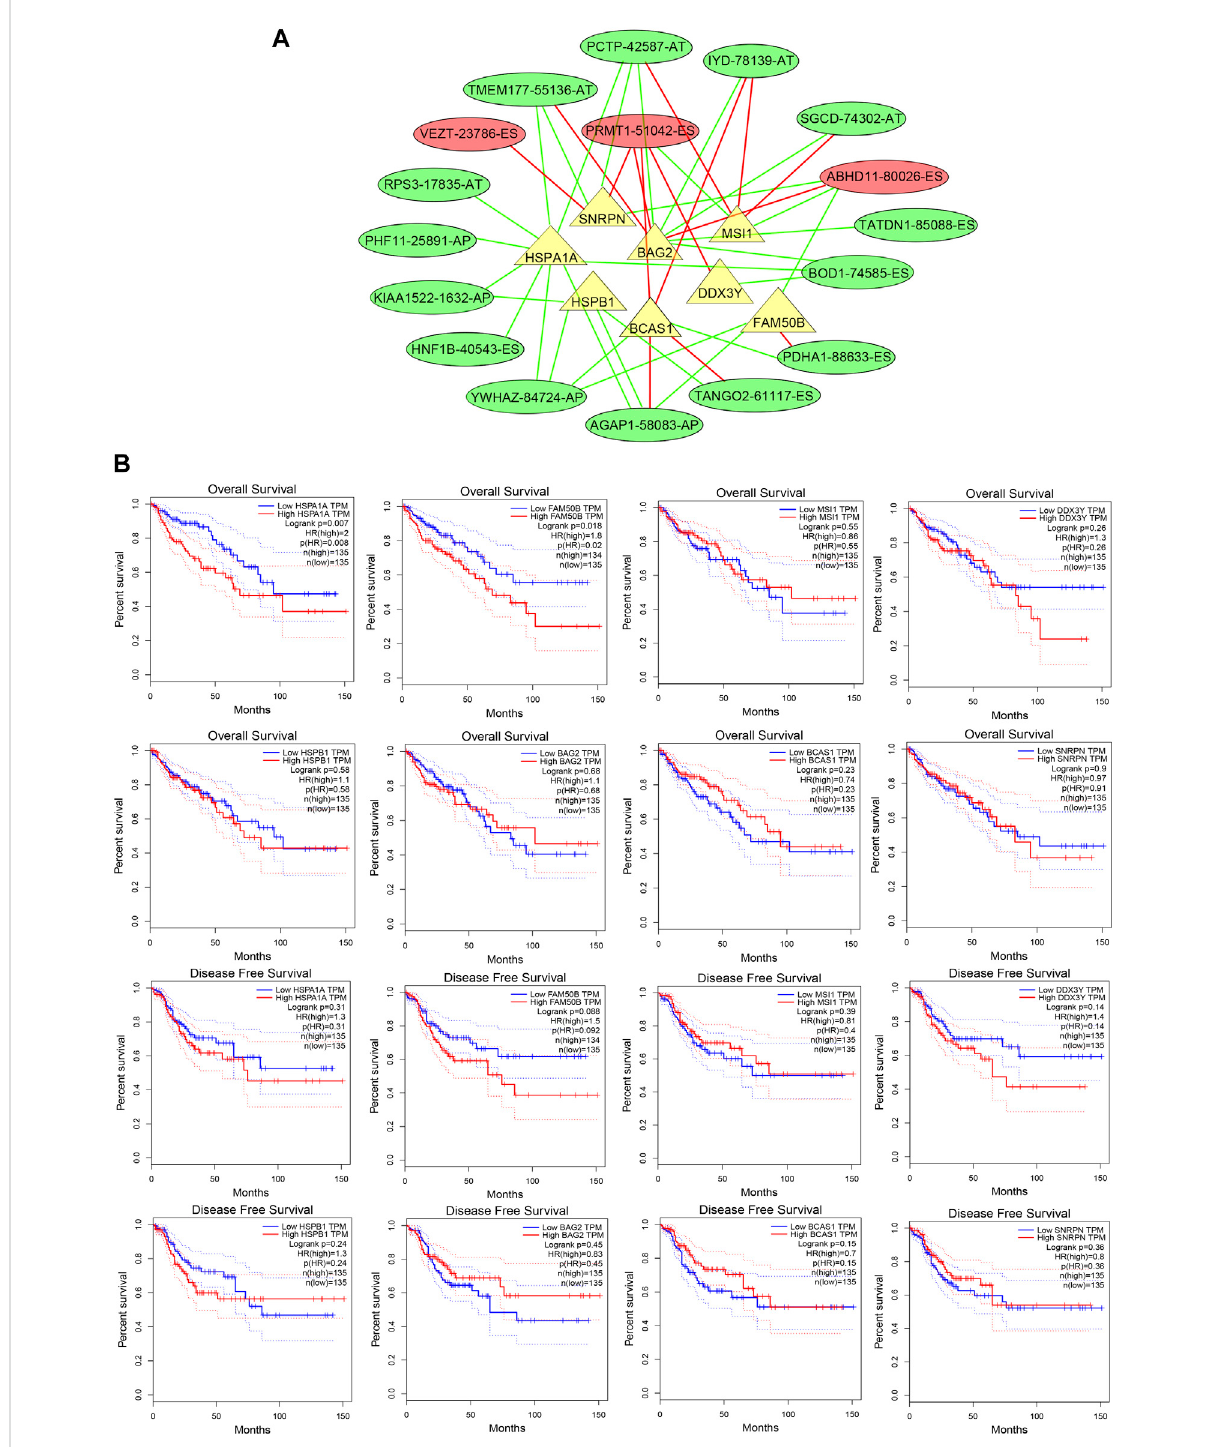
FIGURE 8 The splicing factors are associated with prognostic AS signature. (A) Splicing correlation network in CRC. The triangles represent the survival- related SF. The red and green ovals represent SREs that increase and decrease risk, respectively. Red and green lines represent the positive and negative correlations of connected triangles, respectively. SRE, alternative splicing events; SF, splicing factor. (B) ROC analysis of overall survival and disease-free survival for the AS signature-related splicing factors in patients with CRC. SF, splicing